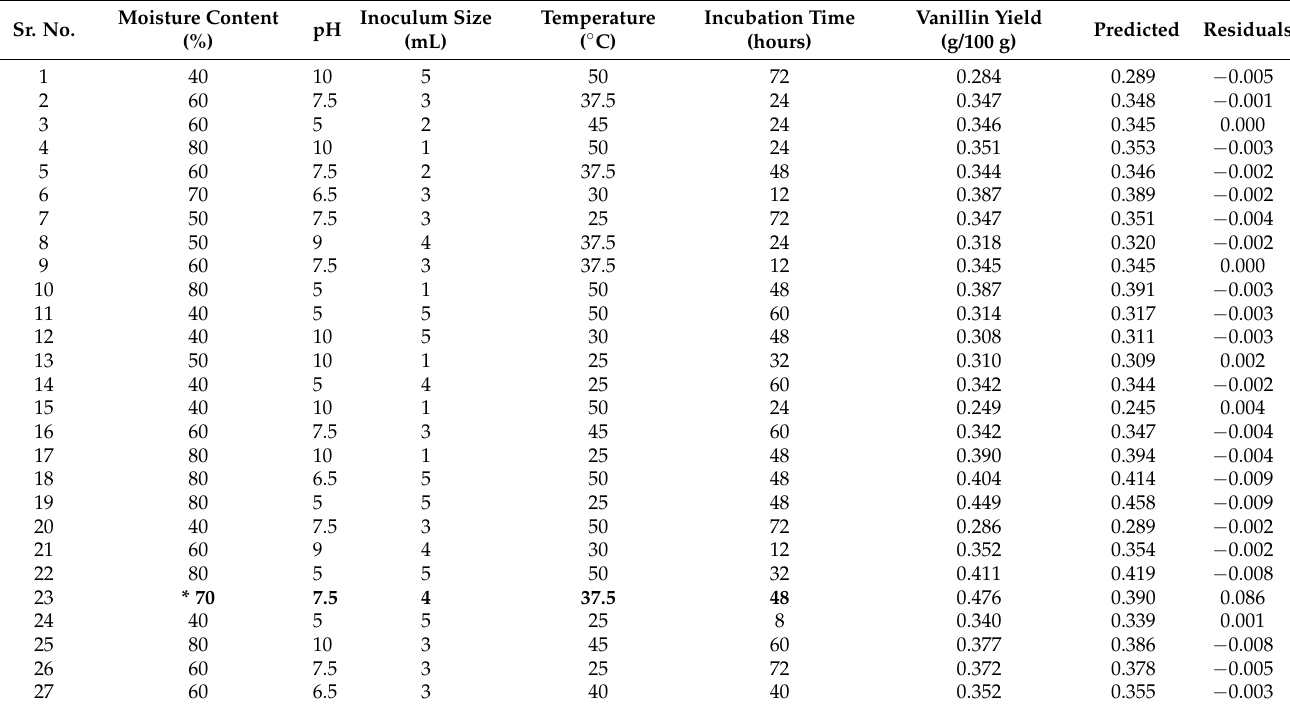
Table 3. Central composite design for the optimization of biovanillin using Saccharum officinarum L. Sr.